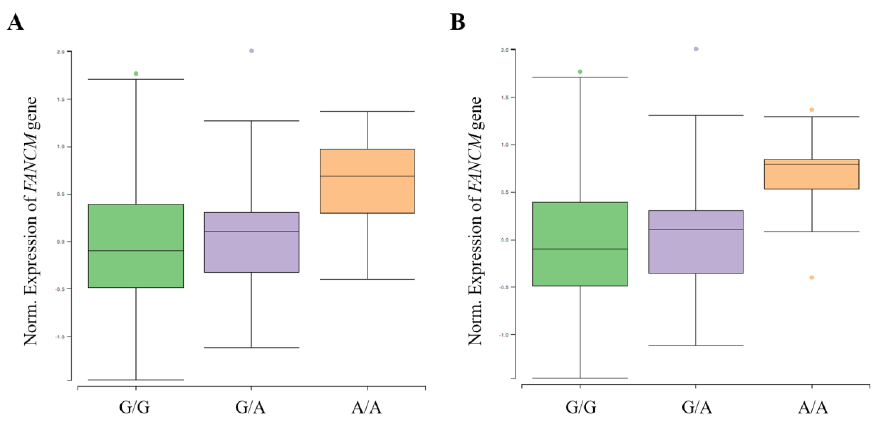
Figure 2. FANCM expression for genotypes rs3783702 ( A ) and rs10138997 ( B ) in glomeruli. The data are from the NephQTL database (http://nephqtl.org/, accessed on 10 May 2021). Gene expression for the rs3783702 ( β = 0.376, p = 0.040) and rs10138997 ( β = 0.389, p = 0.027) genotypes in glomeruli were confirmed and were statistically significant. p -values were calculated by linear regression.